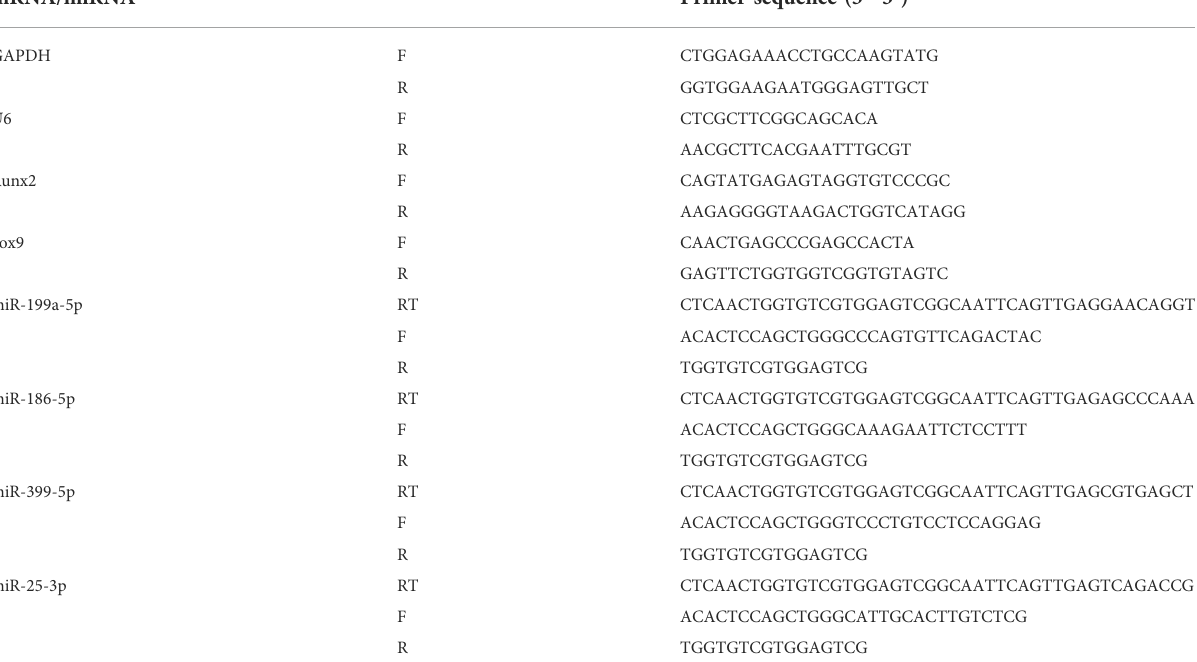
TABLE 3 miRNA and mRNA primer